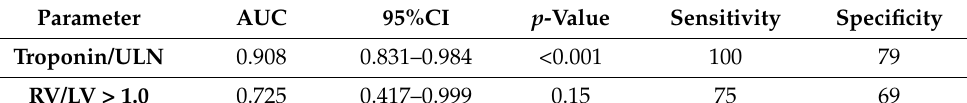
Table 2. ROC analysis of troponin and RV/LV in the prediction of a complicated clinical course.